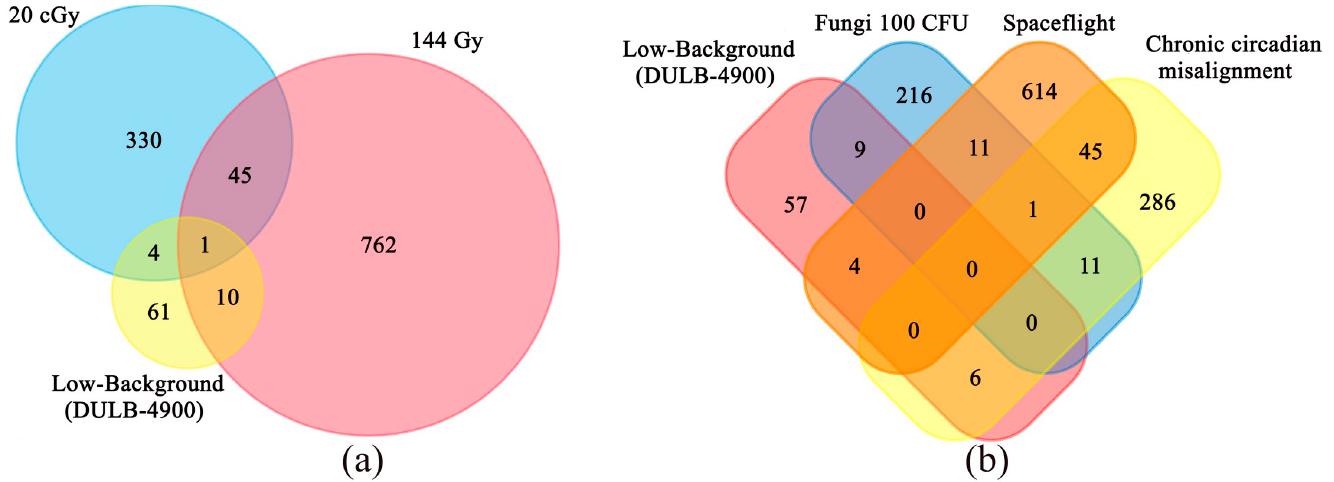
Fig 5. Diagram representing the quantity of shared genes for D . melanogaster developed in the low-background conditions of DULB-4900 and after different treatments: Irradiation with low (20 cGy), high (144 Gy) doses of ionizing radiation (a) and fungal treatment, spaceflight, chronic circadian misalignment (b).